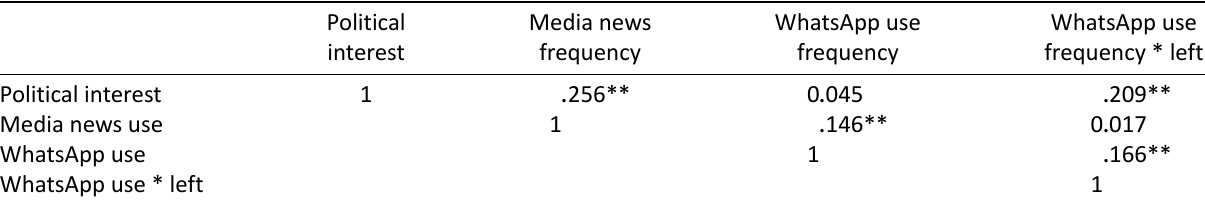
Table 2. Colombia: Covariates correlation (Pearson coefficient).